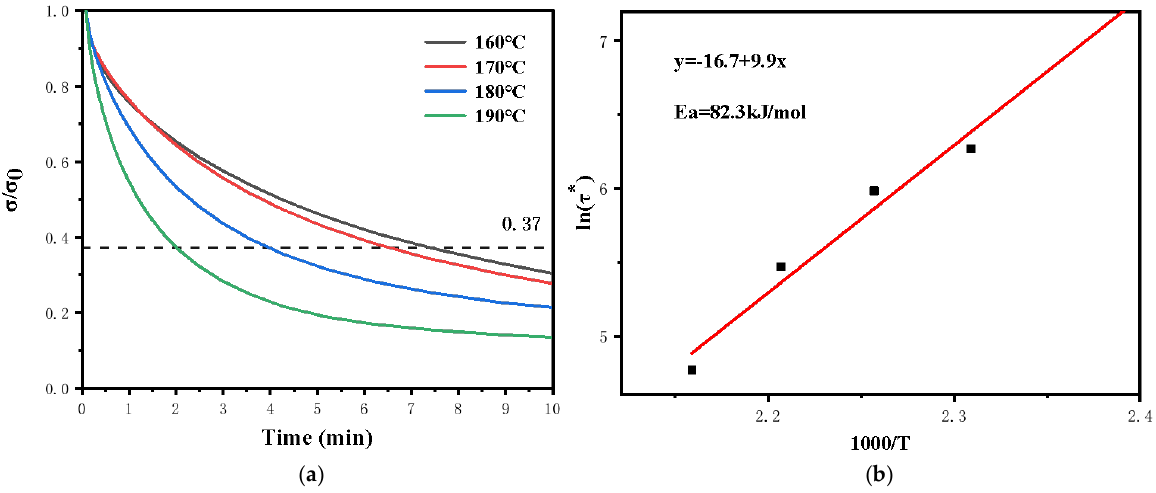
Figure 4. ( a ) Stress relaxation curves of VAN-AC-EP/DDM from 160 °C to 190 °C; ( b ) linear fitting curve based on Arrhenius’ law.